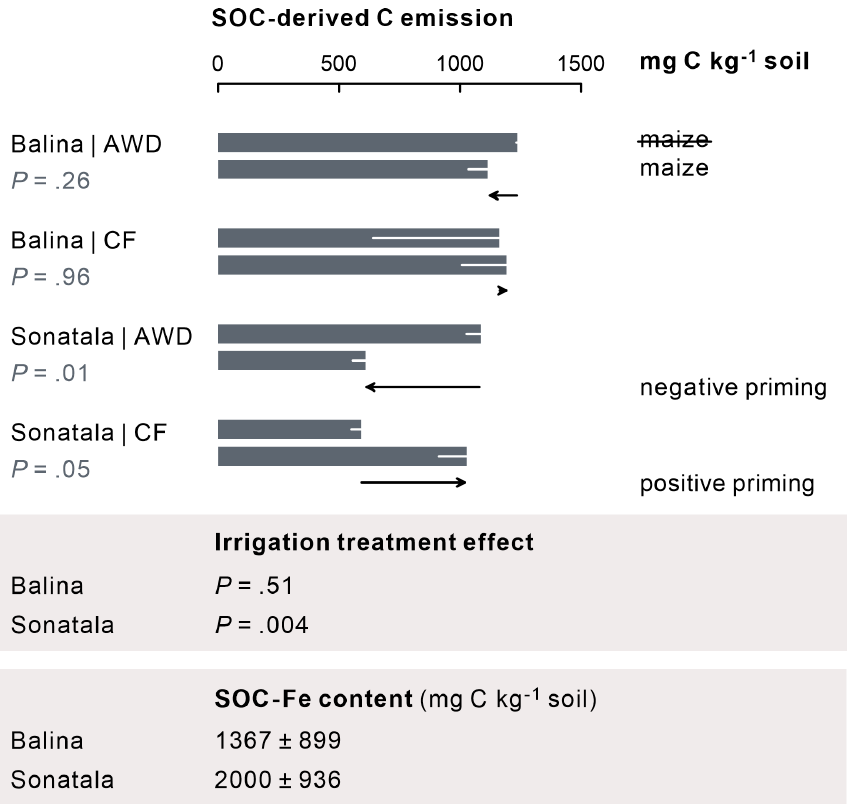
Figure 7. For the Sonatala soil, maize addition led to positive priming of gaseous C (CO 2 + CH 4 ) emission under CF and negative priming under AWD. P -values of the priming effect significance (in the figure) and of the irrigation treatment effect on the priming effect (below the figure) are indicated. Standard errors (three or two replicates) are indicated. Fe-bound SOC levels (average ± standard error, estimated (cid:113) by means of NH 2 OH HCl) exceed the positive priming effect of Sonatala under CF, so stimulated Fe-C dissolution and emission has the potential to explain this